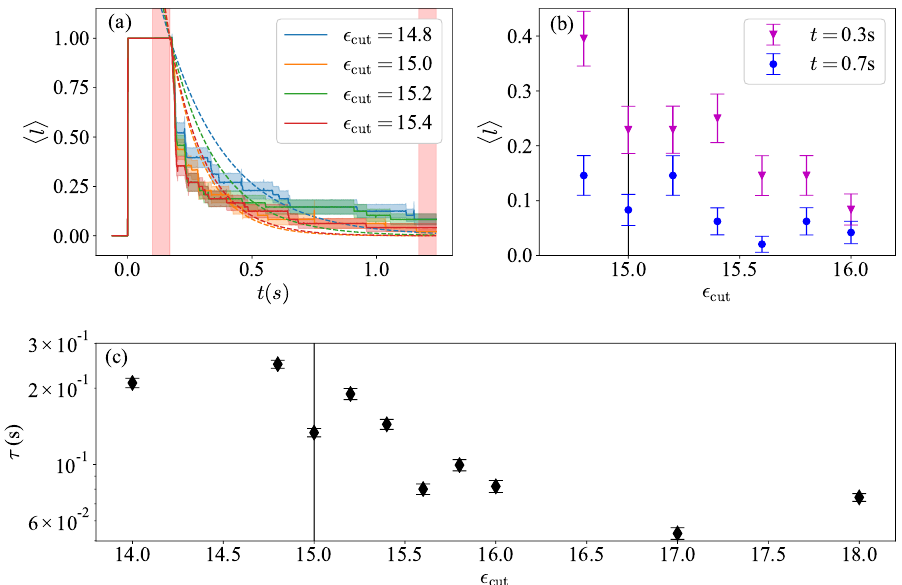
Figure 12: Variation of average winding number and decay timescale as the energy /µ = 0.77. Here the cutoff ε is adjusted, for the temperature T = 85nK and V b cut value of the cutoff ε is given in units of ħ h ω . (a) The average winding number as a r cut function of time for different values of ε , where time periods corresponding to the cut ramping up and down of the barrier are shown in shaded red. Exponential fits to the data are given by the dashed curves. (b) The average winding number at fixed points in time, as a function of energy cutoff. (c) The decay timescale τ , calculated by fitting the trends in (a) to Eq. (15), as a function of ε . In (b) and (c) the black vertical line cut gives the precise cutoff value estimated from Eq. (6). The average winding number is obtained by averaging over an ensemble of 48 SPGPE trajectories, with error bars giving a 95% confidence interval (two standard